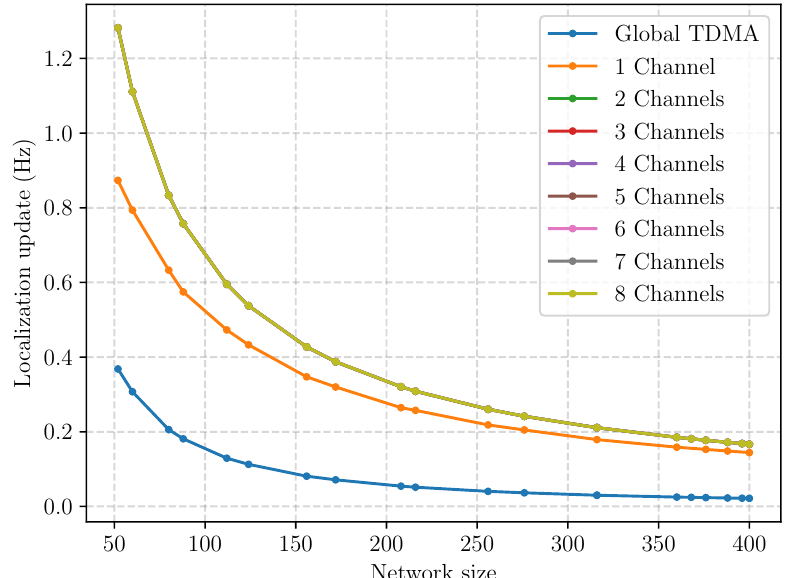
Figure 23. Frequency of position update according to the number of channels at 6.8